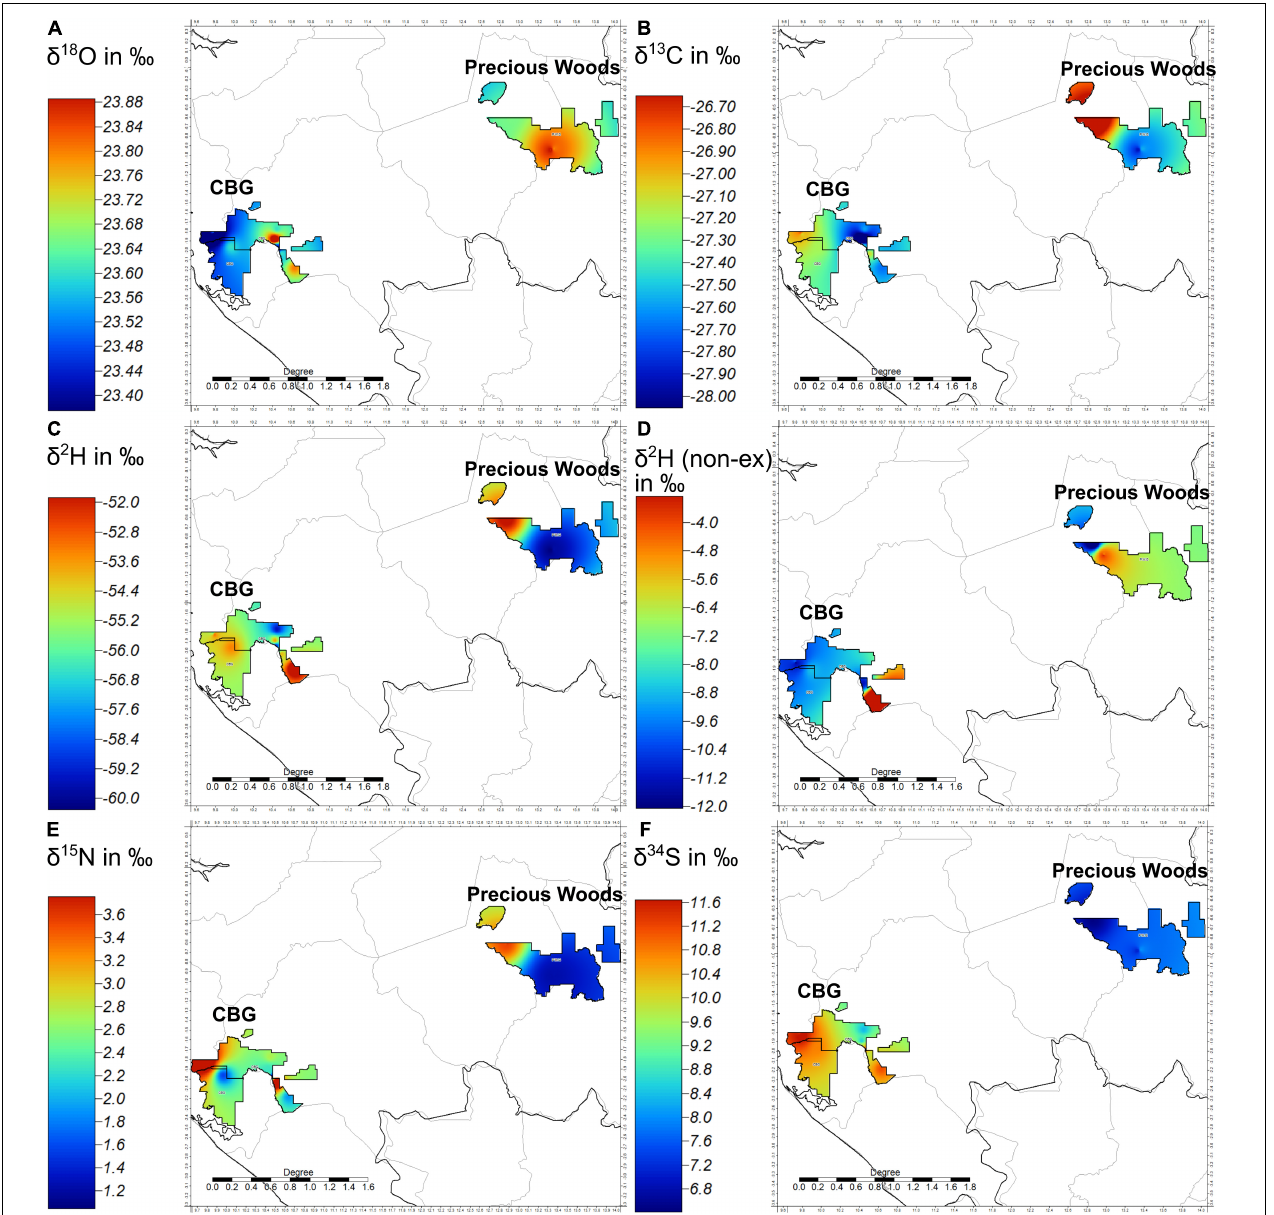
FIGURE 5 | Inverse distance weighting (global) isoscapes of Aucoumea klaineana stable isotope data from samples collected in the C.B.G and P.W.G concessions. (A) δ 18 O, (B) δ 13 C, (C) δ 2 H, (D) non-exchangeable δ 2 H from cellulose, (E) δ 15 N, (F) δ 34